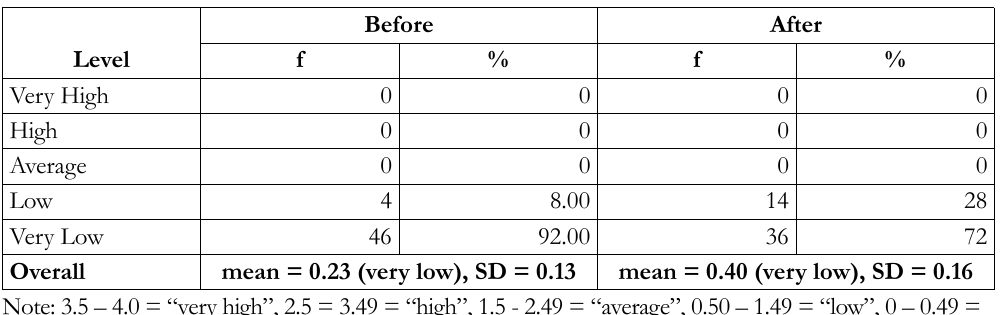
Table 4. Level of Problem Solving Skills of the Non-PBL